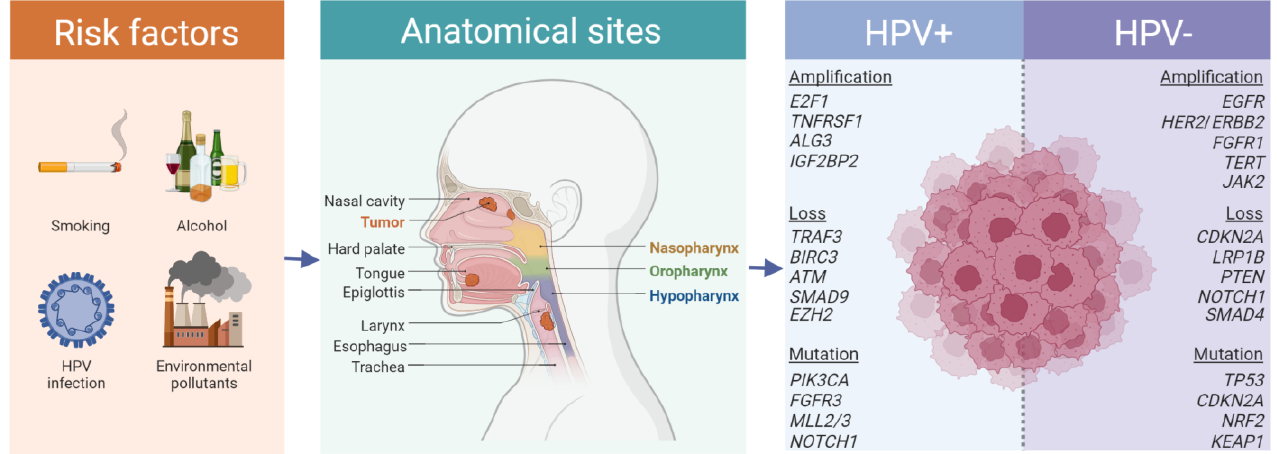
Figure 1. Risk factors, anatomical sites and recurrent mutations in HNSCC. HNSCC is generally subgrouped in HPV+ and HPV- subsets. Common (but not entirely exclusive) genomic alterations per subtype are indicated.